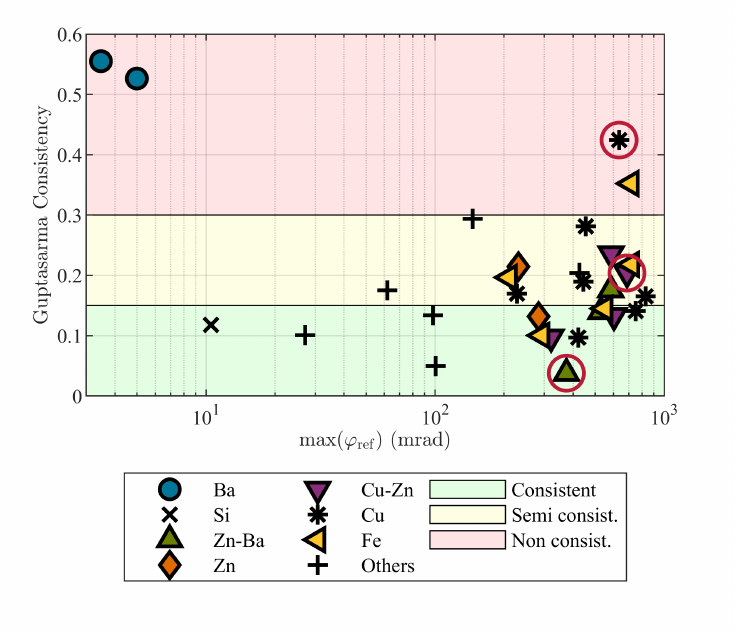
Figure 6. Guptasarma consistency vs. maximum phase shift for the entire dataset according to the definition given by Equation (13). The symbols follow the convention used in Spagnoli et al. [13]. The colored regions indicate the categorization according to Equation (14). The red circles indicate the specific samples selected in Figure